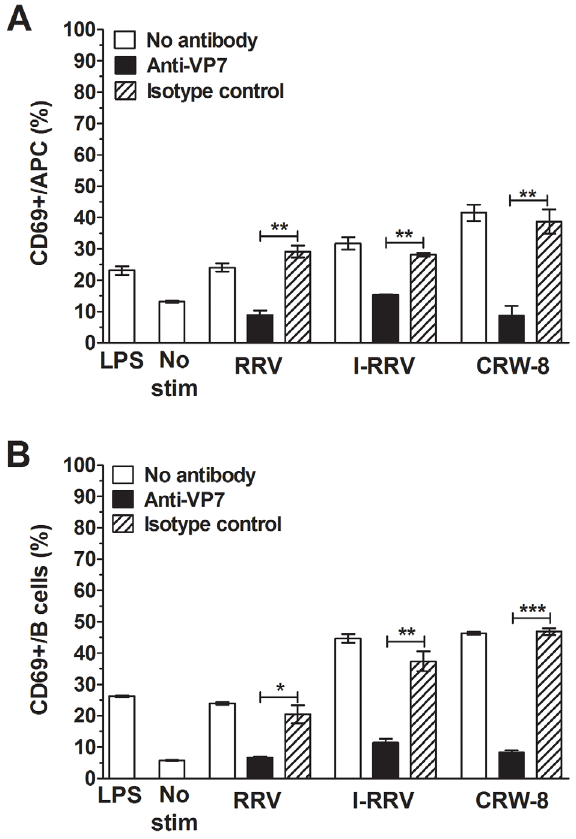
Figure 3. Neutralising antibody blockade of VP7 reduced APC and B cell activation. NOD mouse splenocytes were stimulated for 24 h with 50 ng/ml of rotavirus treated with anti-VP7 antibody (RV-3:1) or isotype control antibody (RV-5:2), or untreated rotavirus. CD69 expression on live APCs (A) and B cells (B) was determined by flow cytometry. Control cells were stimulated with 50 ng/ml of LPS or left unstimulated (No stim). Data are derived from one experiment and are representative of two independent experiments. Error bars indicate the mean 6 SEM of 3 replicates. * p , 0.05, ** p , 0.01 and *** p , 0.001.